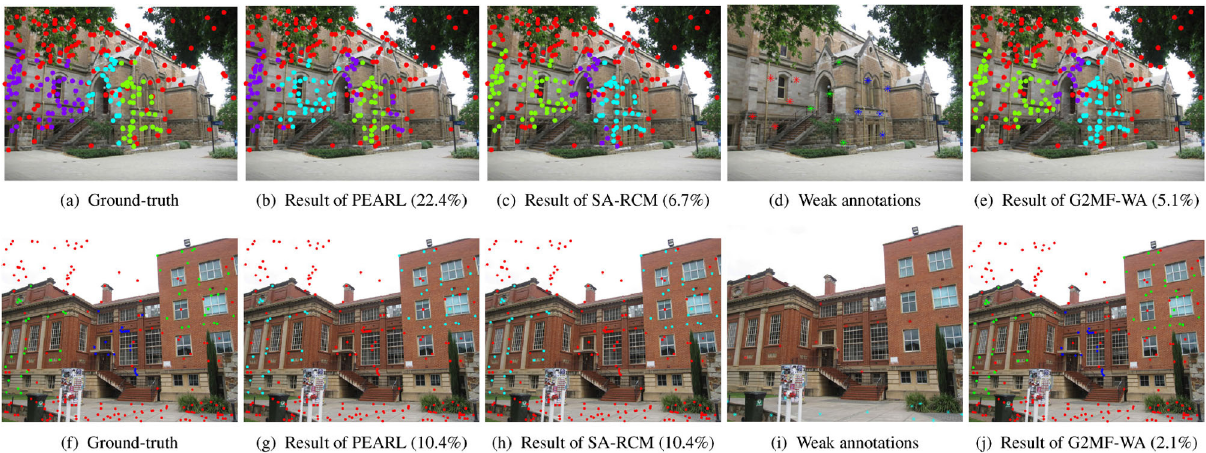
Fig. 5 Examples of multi-homography detection. Above: elderhallb shows the situation when the number of weak labels in (d) equals the number of ground-truth labels (a) without considering the outlier label (red circle in (a)), i.e., 3 labels in (d) and 4 labels in (a) including the outlier. Below: barrsmith shows the situation when the number of weak labels in (i) differs from the ground truth. In (d) and (i), WA data points are shown. Table 1 Median results over 100 trials on the multi-homography detection task with full AdelaideRMF dataset (H part). Darker colors represent lower errors (%) and runtime (in seconds), denoted by fuchsia and cyan, respectively. The top-3 cells in each row are colored Method PEARL